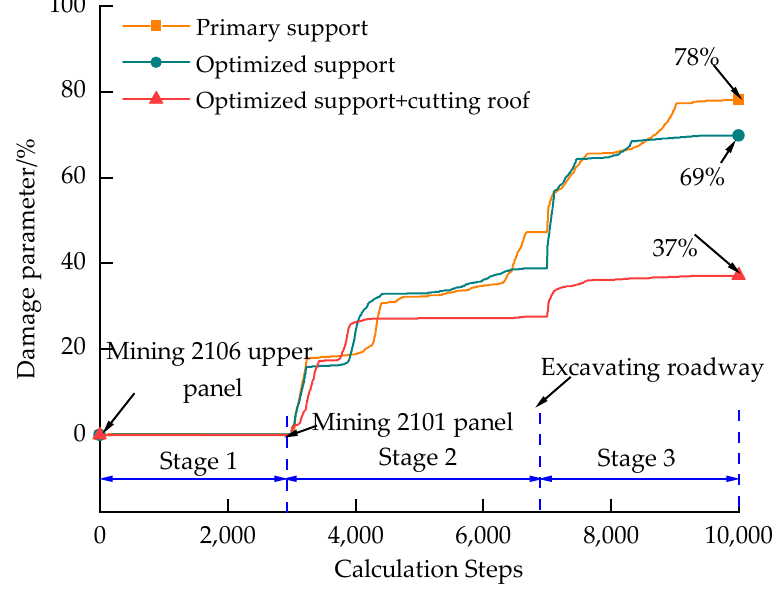
Figure 15. Evolution of damage parameters with increasing calculation steps.